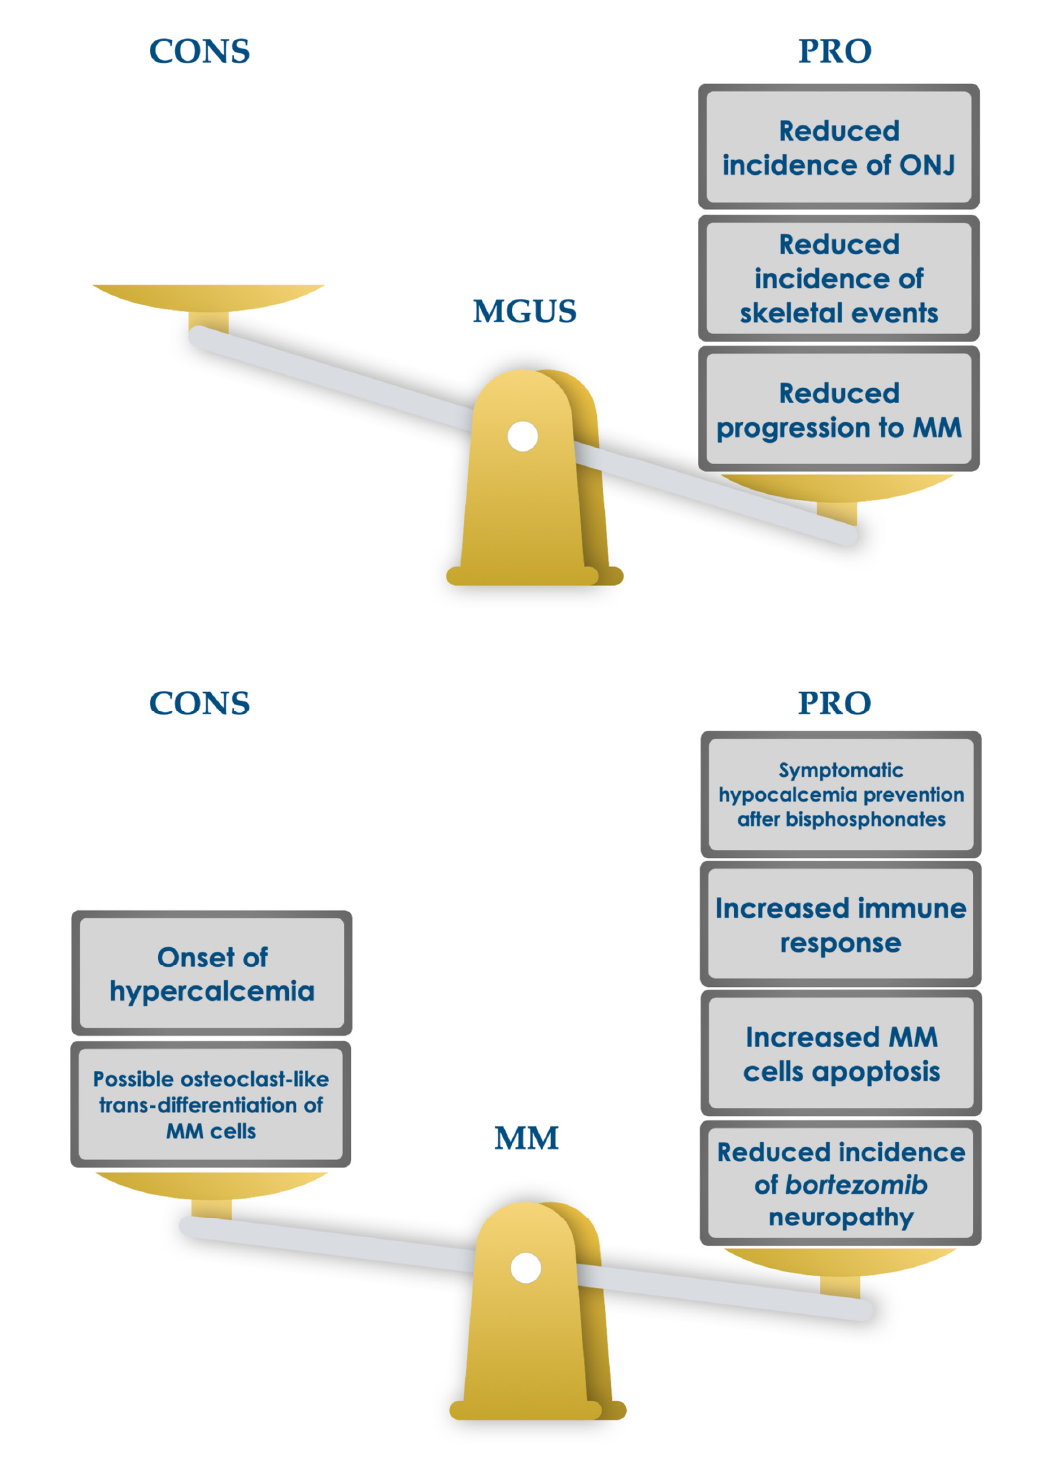
Figure 2. Possible unfavorable and favorable effects of vitamin D administration in MGUS subjects and MM patients [144– 150].